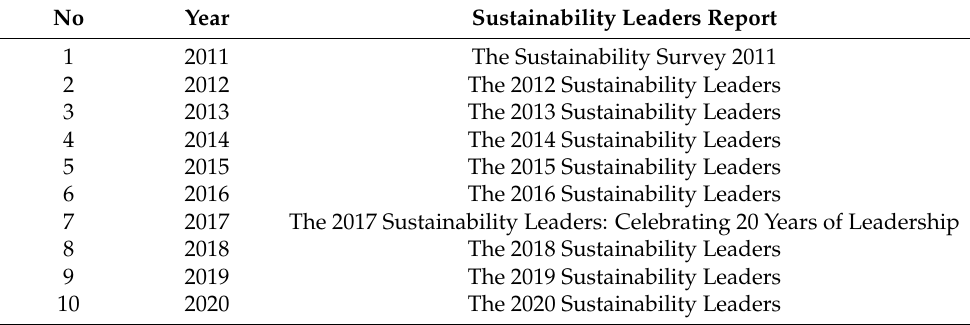
Table A1. List of Sustainability Leaders Survey Reports from 2011 to 2020.